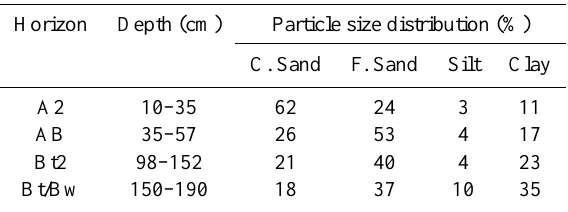
Table 1. Physical properties of the selected horizons of Argissol according to Melo and dos Santos